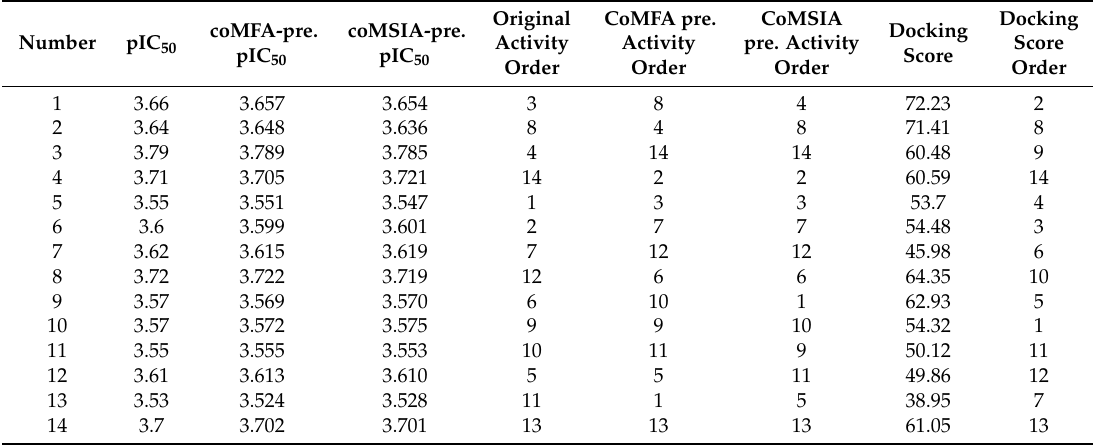
Table 5. The relative experimental and predicted (pre.) values order of 14 xanthones